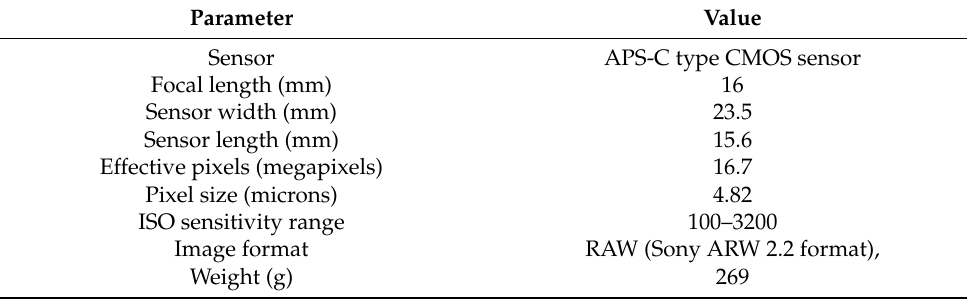
Table 3. Sony NEX 5N camera sensor